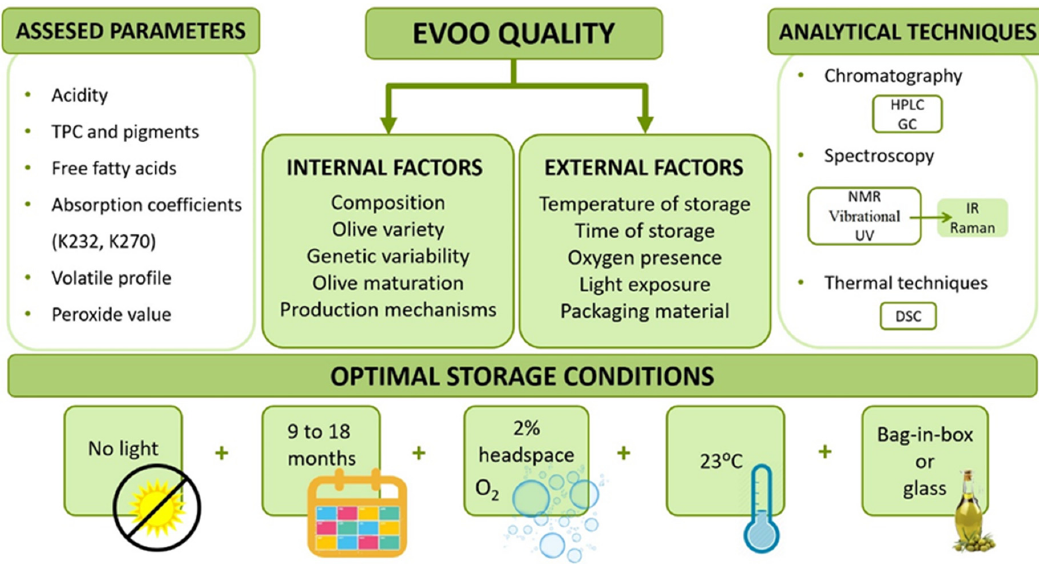
Figure 4. Parameters and factors concerning EVOO quality and its